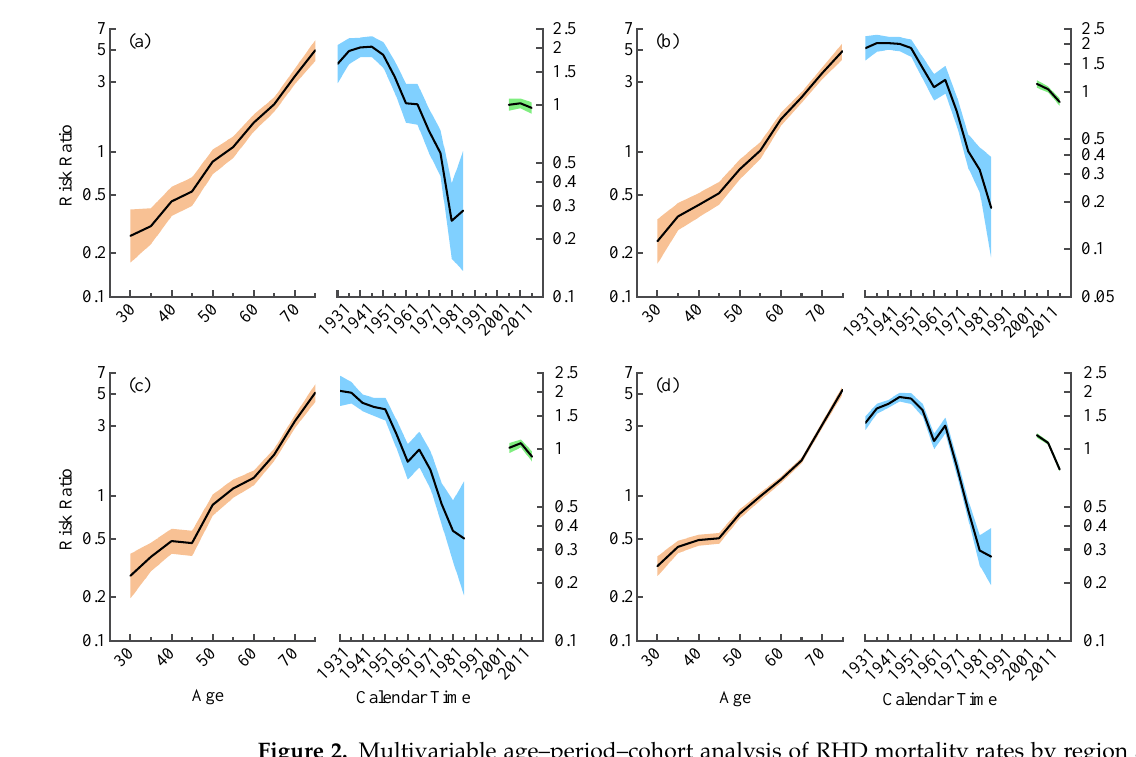
Figure 2. Multivariable age–period–cohort analysis of RHD mortality rates by region and sex in China from 2006 to 2020. For the 3 line graphs, the left lines represent age effect, the middle lines are the estimated birth cohort effect, and the short lines refer to the period effects (risk ratio). The shaded areas surrounding the lines represent the 95% confidence intervals. ( a ) Urban male, ( b ) urban female, ( c ) rural male, ( d ) rural female.